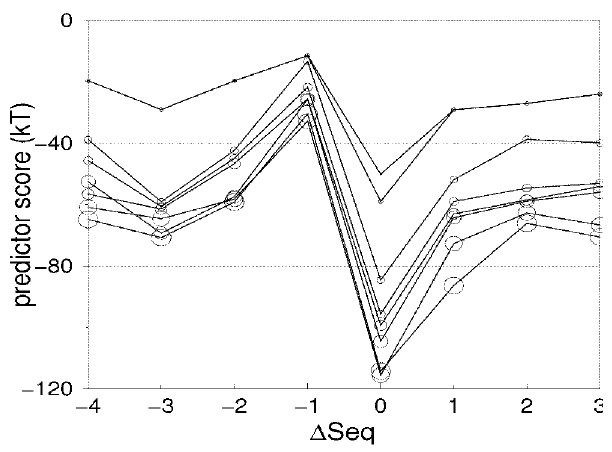
Figure 6. Optimization of the ANOLEA/SSE Local predictor specificity. The highest specificity is attained for an inter-residue distance cut-off of all pairs of heavy atoms of 4 A˚ as deduced from the scan by step of 0.5 A ˚ from 2 to 6 A ˚ for all the test cases. ANOLEA/SSE Local predictor scores for 1flp helix1 test case versus alignment offset to the structural alignment and for different inter-residue distance of all pairs of heavy atoms (from 2 A˚ (smallest sphere) to 6 A˚ (biggest